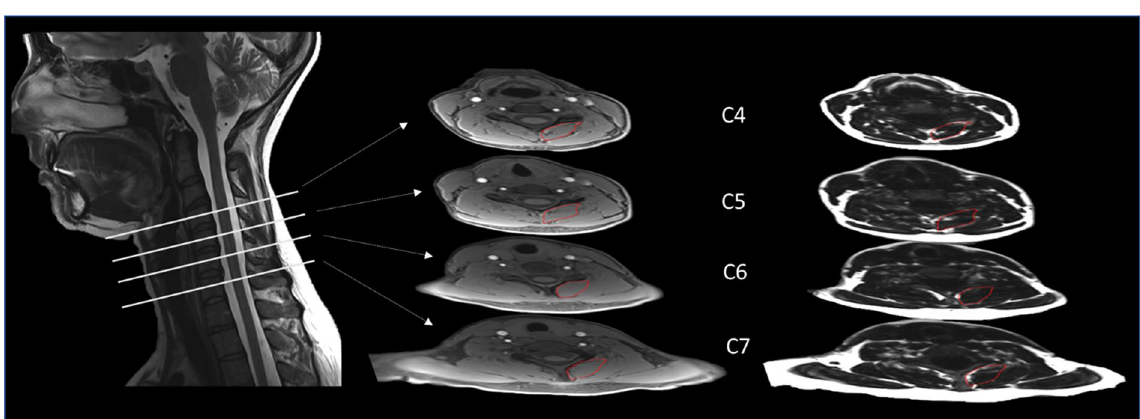
Figure 3. Schematic illustrating how fat infiltration into neck muscle (MFI) was measured via magnetic resonance imaging (MRI). Fat and water in the neck was measured via T2-weighted sagittal MRI of the Cervical Spine in four cross-sections (left, C4–C7). In each of these sections, water (middle) and fat (right) were quantified in the areas outlined in red (fascial borders of the multifidus-semispinalis cervicis) on both the left and right sides. The mean signal intensity for fat and water was used to quantify MFI percentage as described in the Methods. These values were calculated for each individual in the cohort and ranged from 10.4 to